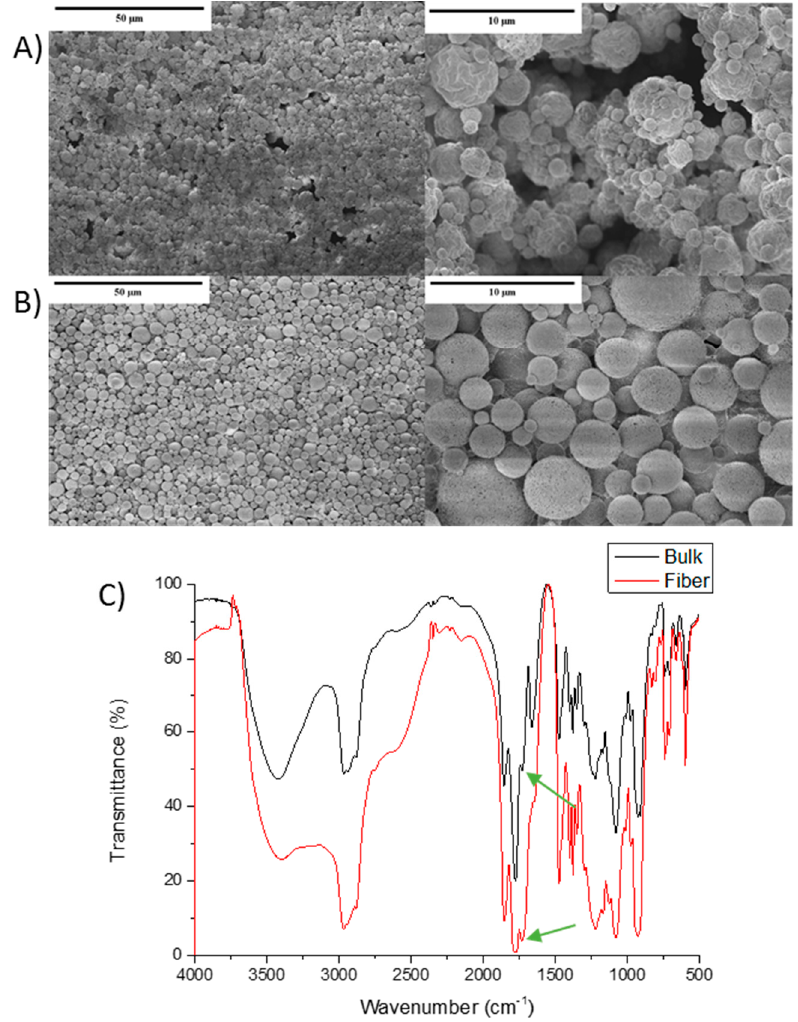
Figure 7. SEM images and fiber diameter of ( A ) the iBu-MA copolymer; and ( B ) the iBu-MA-PEG electrospun hydrogel (nanoparticles); and ( C ) the FTIR spectra of bulk hydrogel and hydrogel particles.